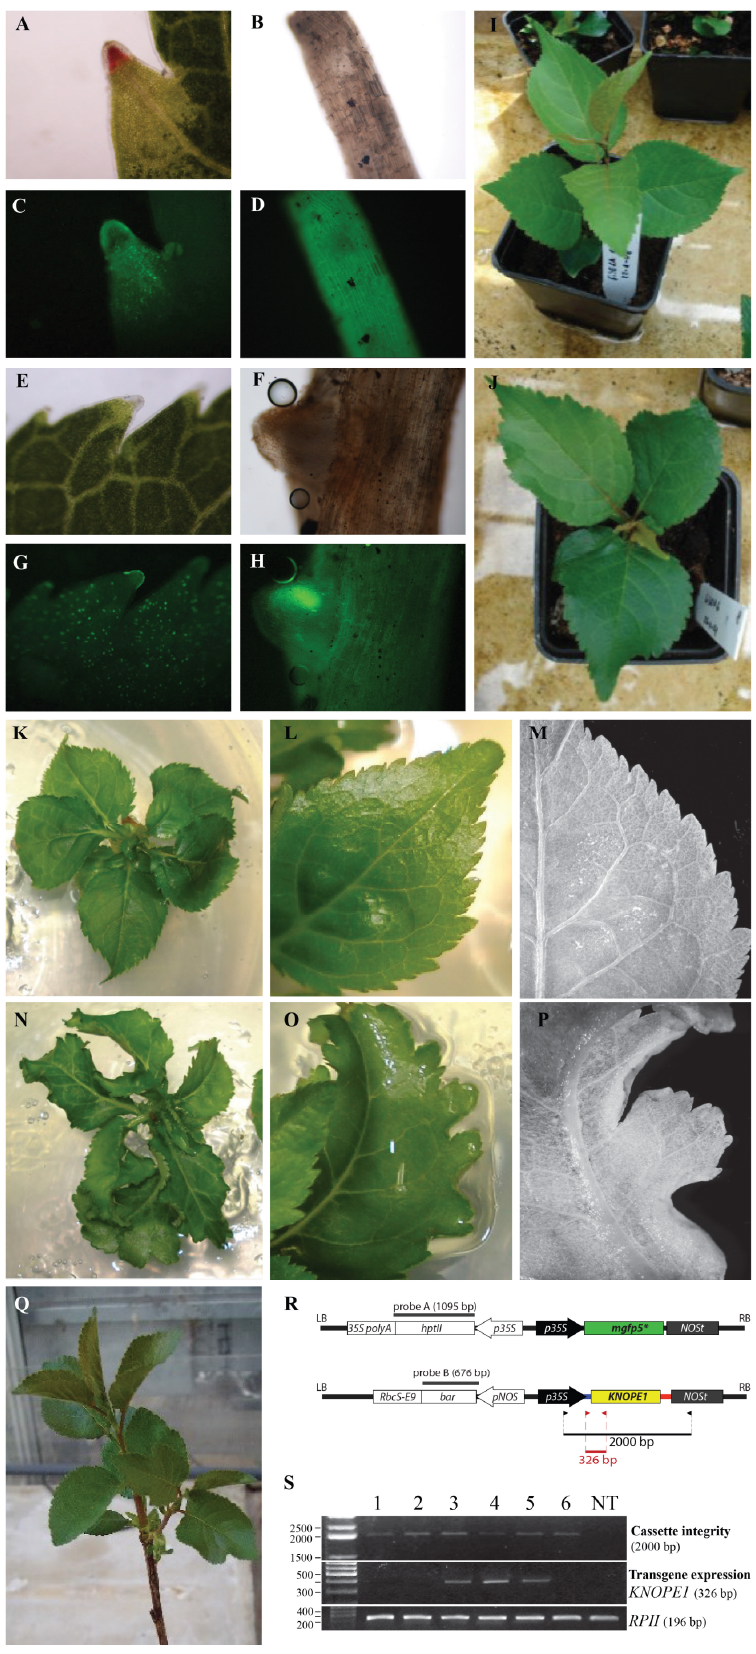
Figure 9. Genetic transformation of Gisela 6. ( A – J ) Examples of GFP fluorescence analysis in